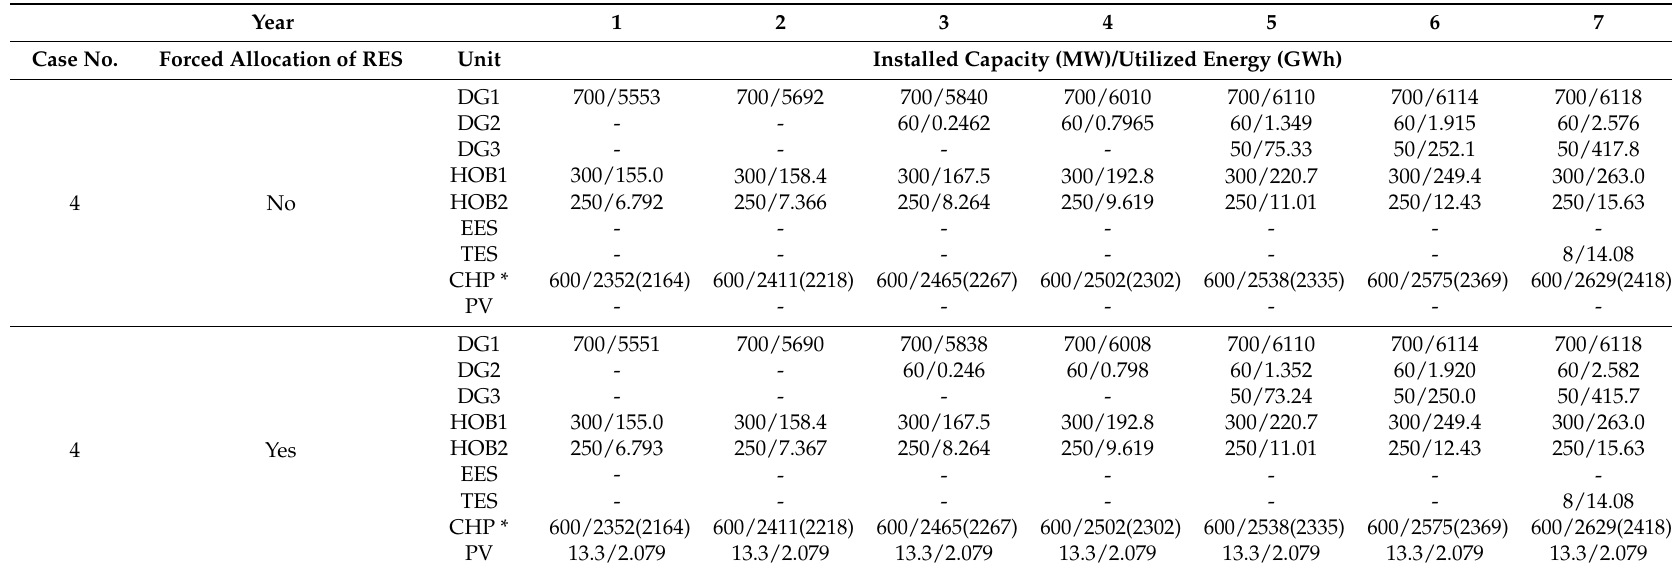
Table 7. Seven-year planning schedules for Case